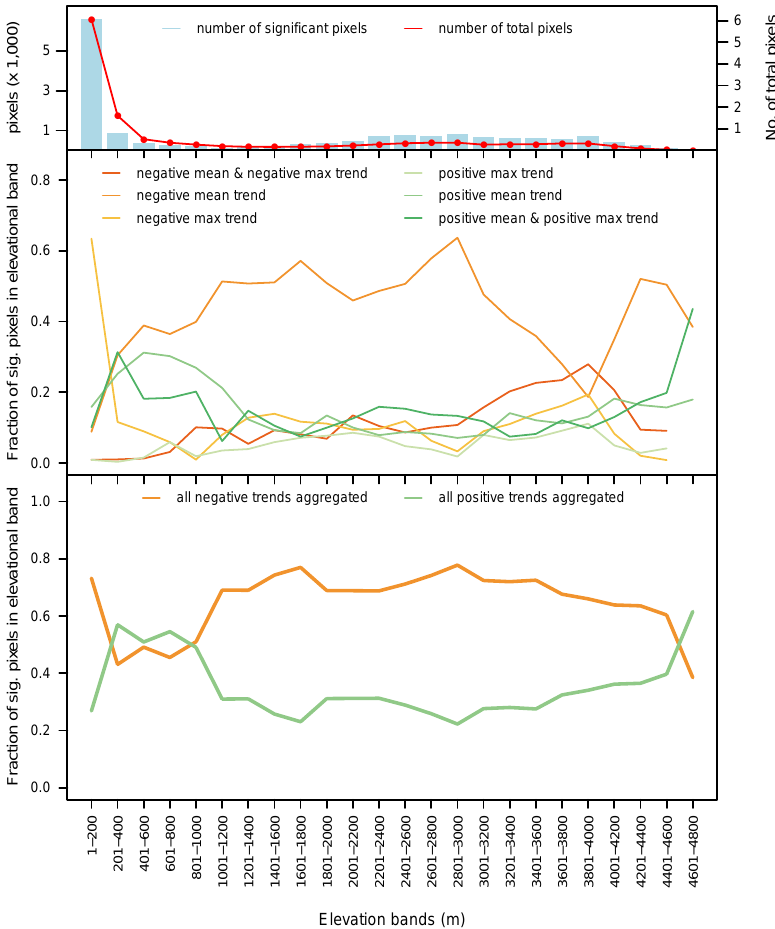
Figure 9. Greening and browning trends in the Tropical Subtropical Dry Broadleaf Forest (TSDBF) by elevation. The vast majority of change was < 200 m, where browning overshadows greening. Refer